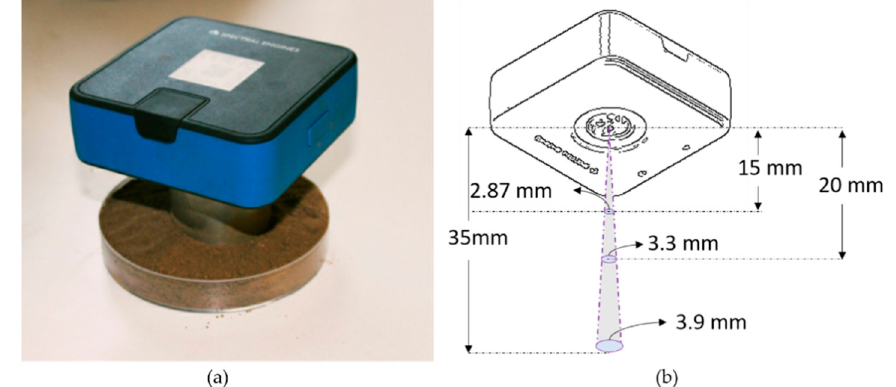
Figure 3. ( a ) MEMS measurement with the application of the 35 mm fitted tube. ( b ) MEMS’ field of view corresponding diameter alterations for various heights.